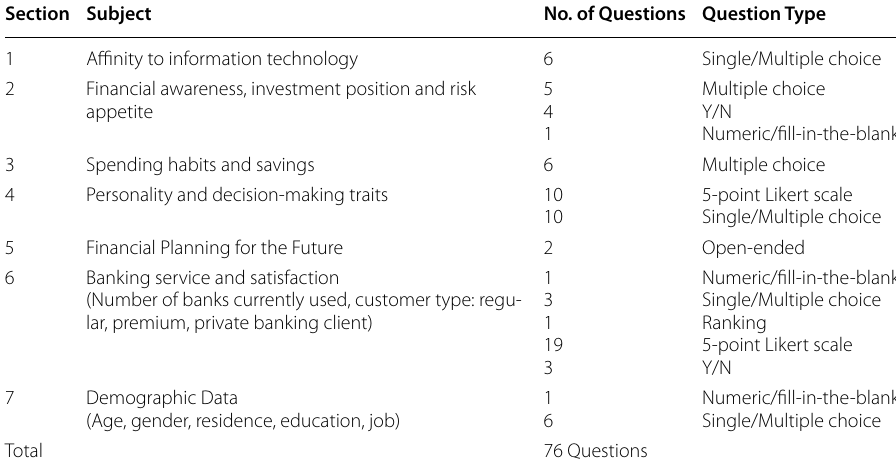
Table 2 The structure of the Dorsum